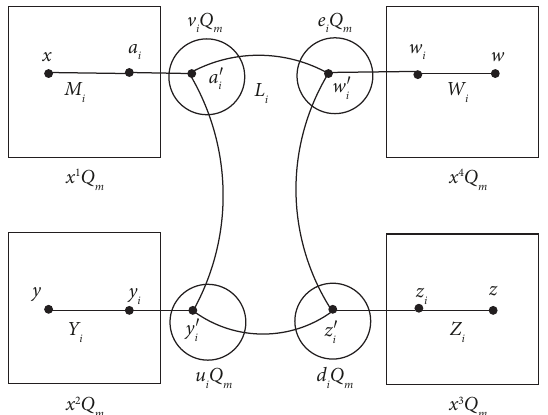
Figure 15: Te illustration of case 4 of Teorem